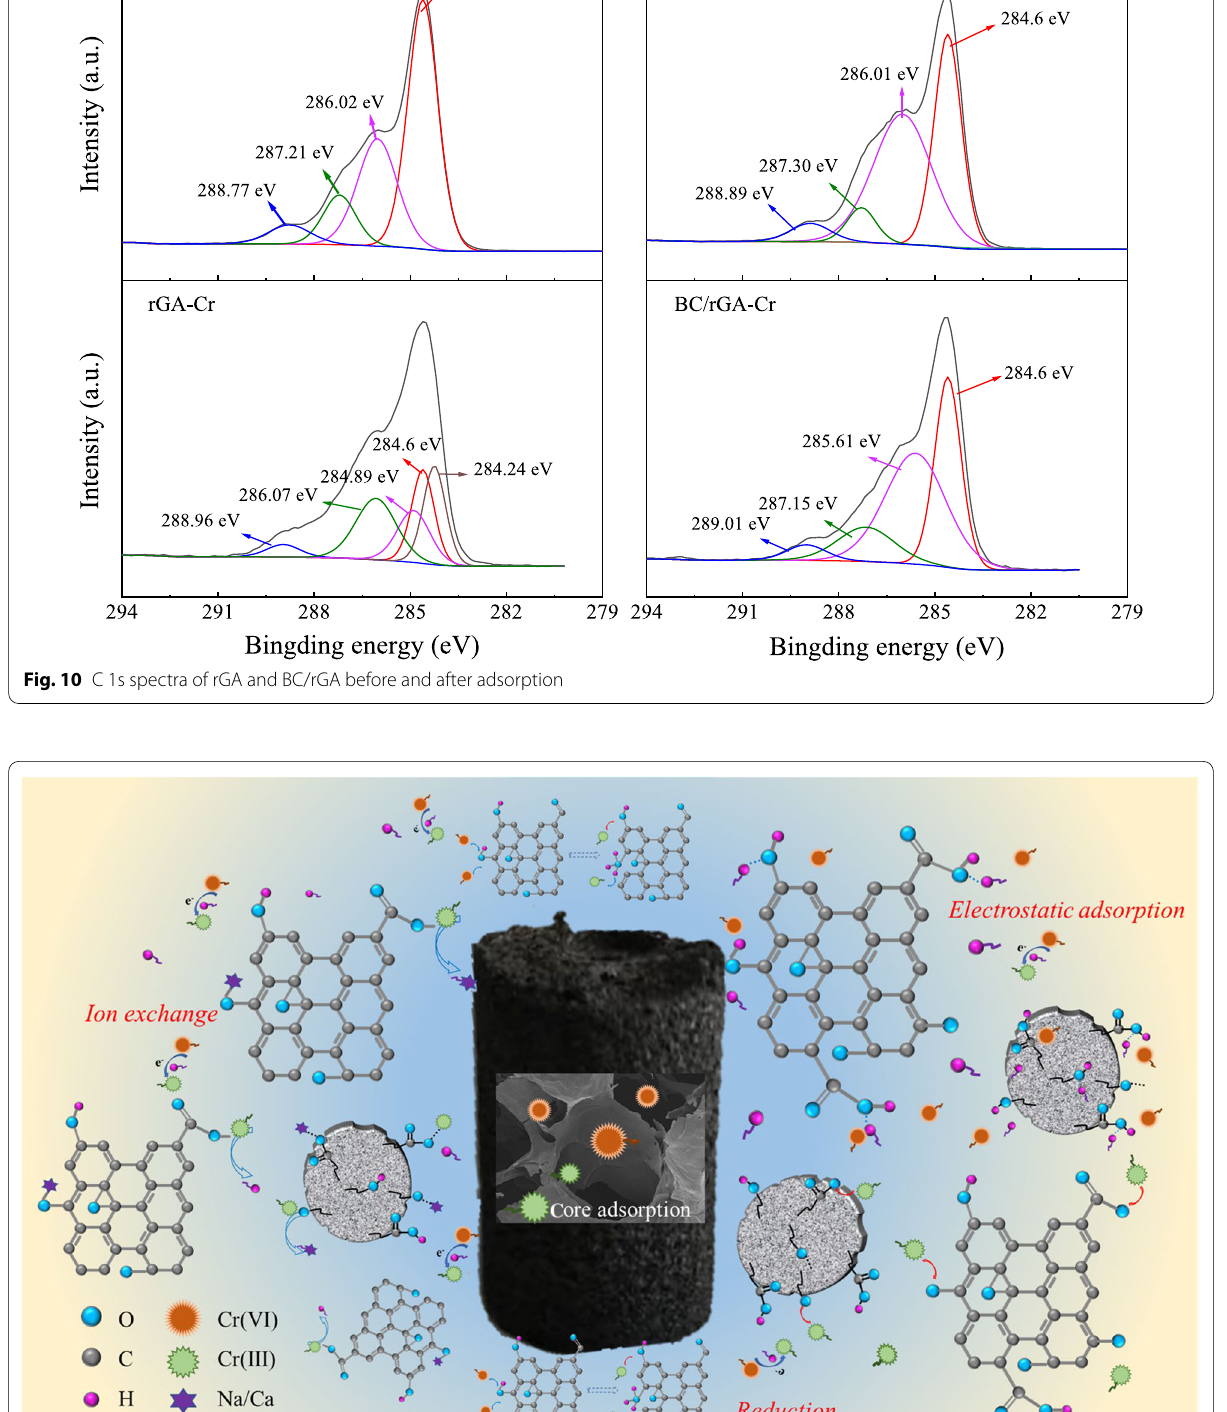
Fig. 11 The adsorption mechanism of Cr(VI) on rGA and